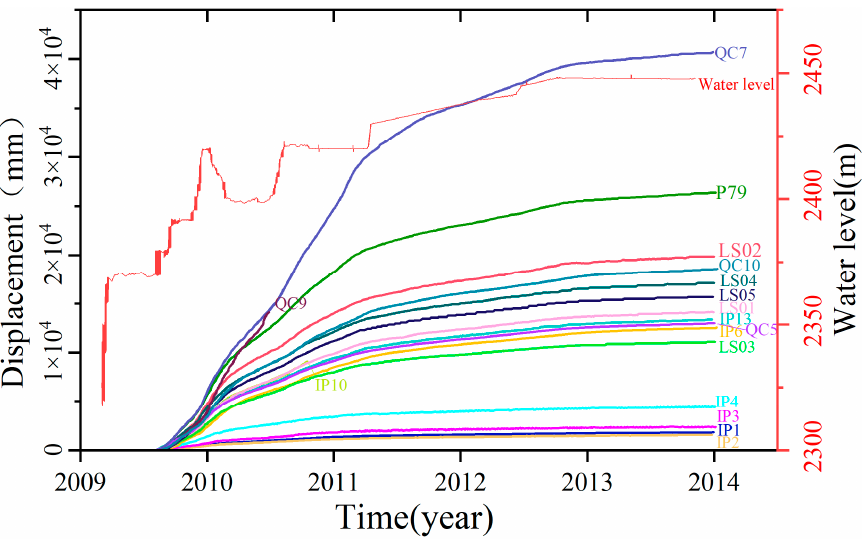
Figure 10. Reservoir water level and vector displacement of GPS monitoring points from 2009 to 2014.